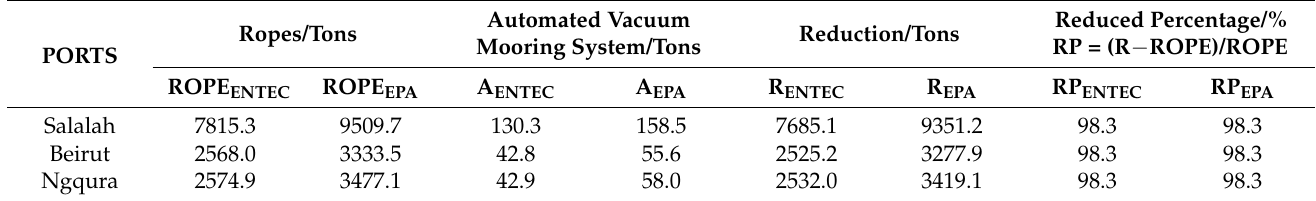
automated vacuum mooring system technology. With the installation of an automatic vacuum mooring system, CO 2 emissions were reduced by 98% (Table 2) [34]. Table 1. Emissions of CO 2 in tons/year during mooring operations with ropes (ROPE) and with automated vacuum mooring systems, and reduction in CO 2 emissions (R) in tons/year and CO 2 emissions (RP) in % using the ENTEC and EPA methods in 2017 (adapted with permission from Ref. [34]. 2021. Díaz-Ruiz-Navamuel, E.).